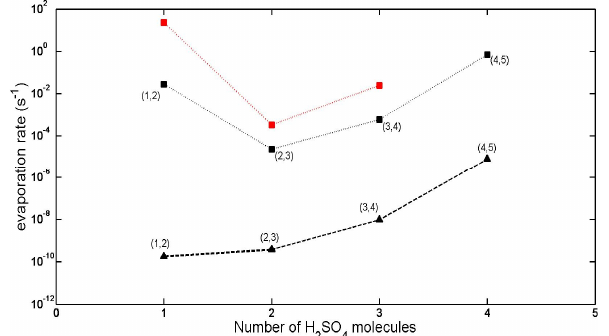
Figure 2. Total evaporation rates at 298.15 K (s − 1 ) for most sta- ble negatively charged clusters versus the number of sulfuric acid Figure 4. Total evaporation rates at 298.15K (s − 1 ) for most sta- molecules in the cluster including the bisulfate ion; that is, 1 corre- ble positively charged clusters versus the number of sulfuric acid sponds to HSO − , 2 corresponds to H 2 SO 4 HSO − etc. Solid lines molecules in the cluster. Dashed lines represent sulfuric acid–DMA 4 4 represent pure sulfuric acid clusters, dashed lines represent sulfu- clusters and dotted lines represent sulfuric acid–ammonia clusters. ric acid–DMA clusters and dotted lines represent sulfuric acid– Black lines represent evaporation rates from this work and the red ammonia clusters. Black lines represent evaporation rates from this line represents evaporation rates obtained using the formation free work, blue lines represent evaporation rates obtained using the the- energies reported by Froyd and Lovejoy (2012). Numbers in paren- oretical formation free energies by Herb et al. (2013) and red lines theses indicate the composition of the cluster (acids, represent evaporation rates obtained using the semi-experimental formation free energies reported by Froyd and Lovejoy (2003). Numbers in parentheses indicate the composition of the cluster (acids, bases).